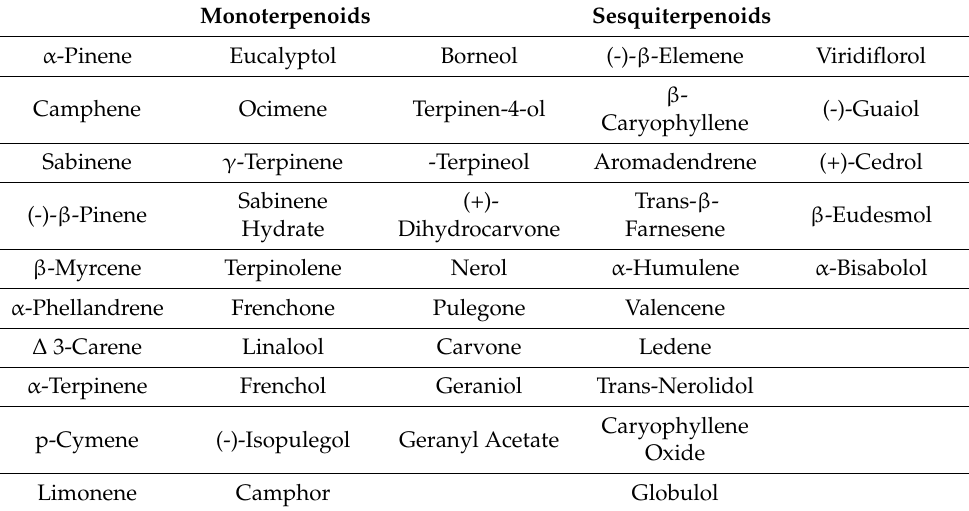
Table 2. Examples of mono- and sesquiterpenoids profiled in cannabis inflorescences, leaves, stem bars, and roots for medicinal purposes [2].